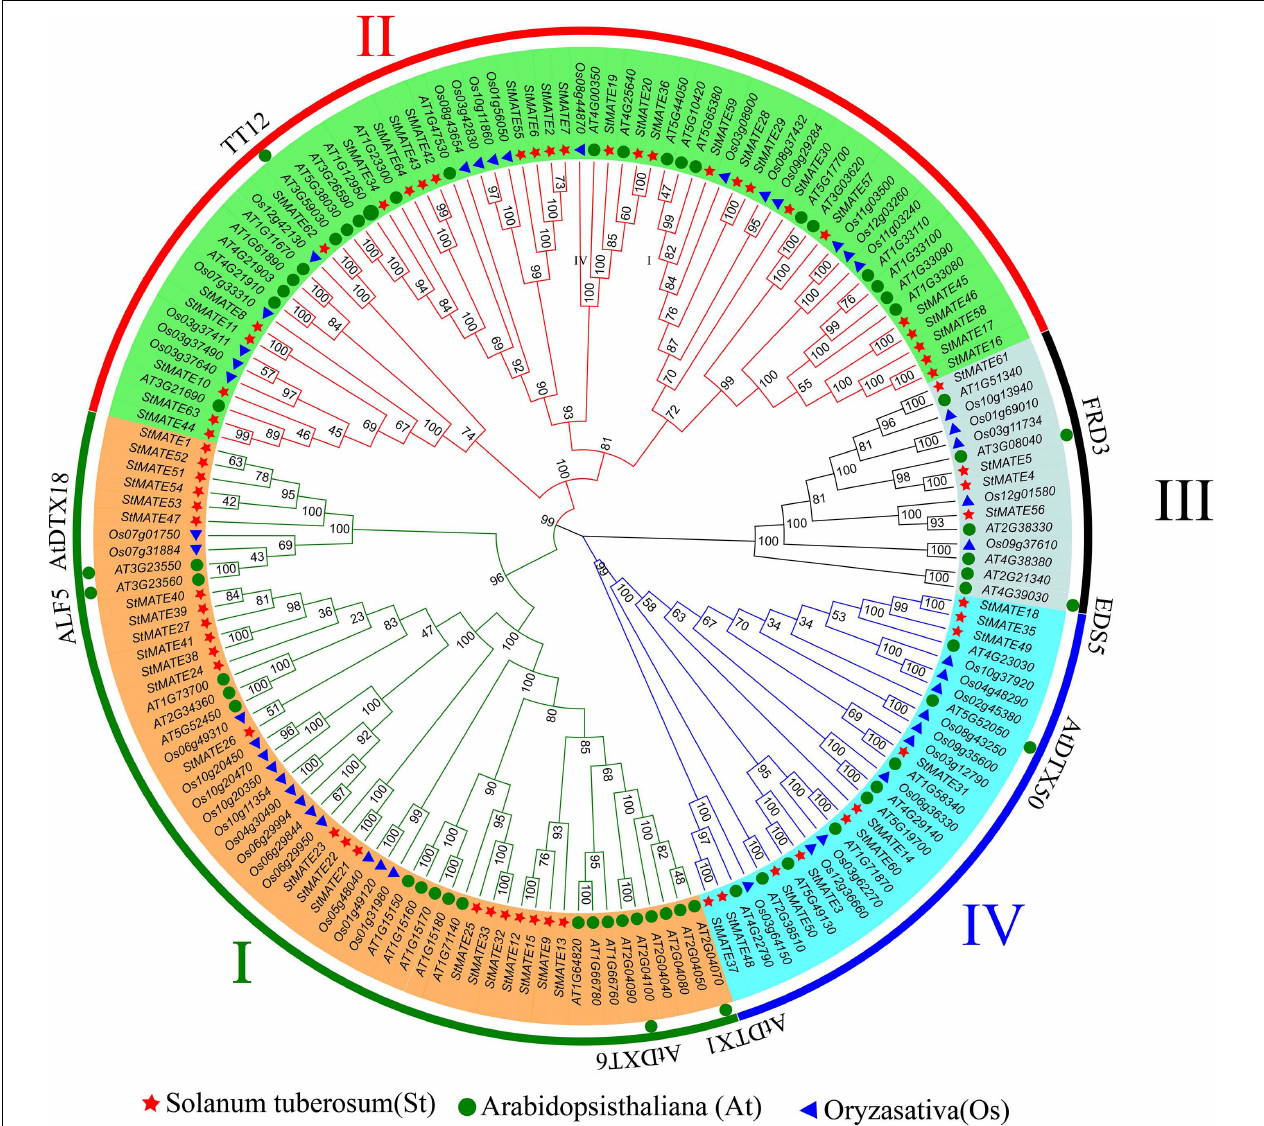
FIGURE 4 | Phylogenetic tree of Arabidopsis , rice, and potato multidrug and toxic compound extrusion (MATE) proteins. The picture represents the phylogenetic tree as constructed by the N-J (neighbor-joining) method where the number on the branch represented the bootstrap values. Subfamilies are marked in different colors, with each subfamily marked outside the circle as I, II, III, and IV. The red star, blue triangle, and green circle represented potato, rice, and Arabidopsis MATE proteins,